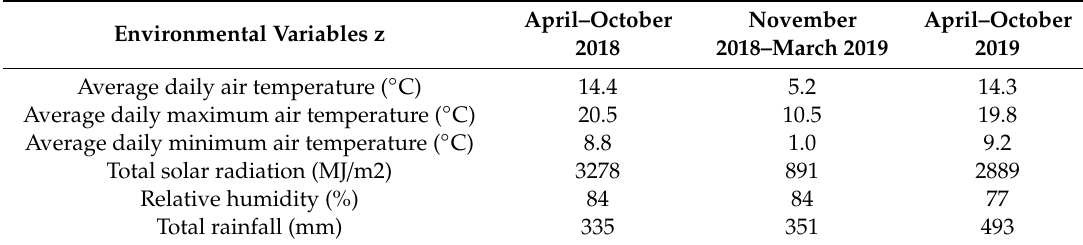
Table 2. Environmental data near the commercial raspberry field used in this study in Northwestern